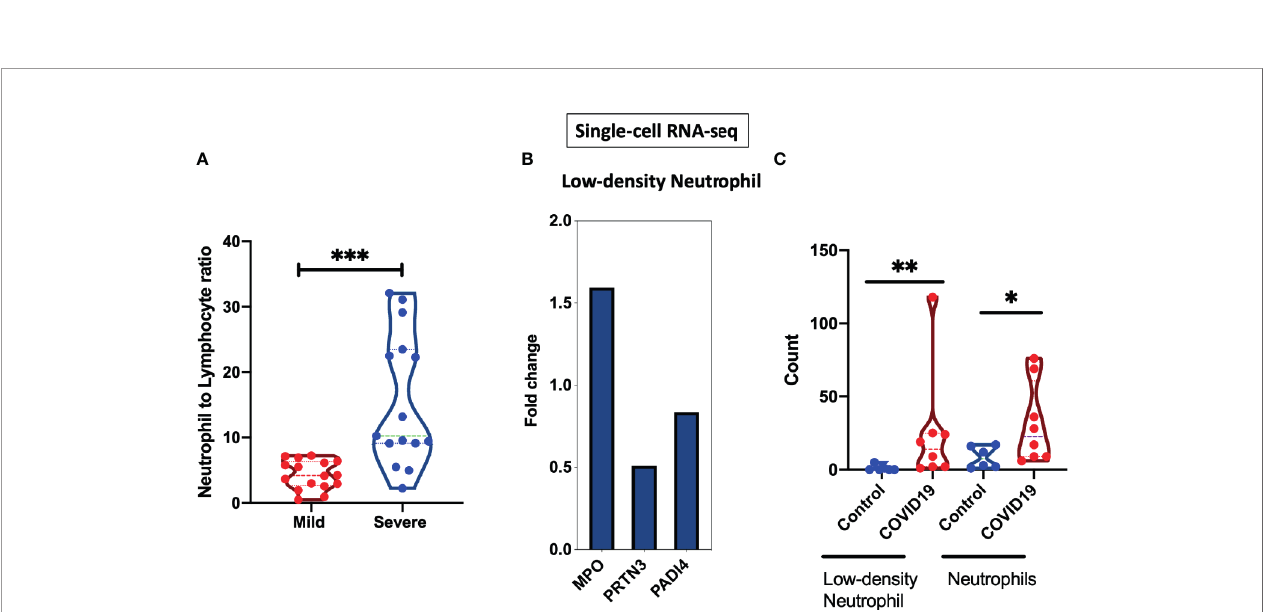
FIGURE 4 | Neutrophil to lymphocyte ratio and gene expression isolated from severe COVID-19 patients. (A) Neutrophil to lymphocyte ratio from whole blood of 16 mild and 15 severe COIVD-19 patients were compared (PRJNA646224). This ratio was signi fi cantly higher in severe COVID-19 (B) Single-cell RNA sequencing was performed on PBMCs from six severe COVID-19 patients and seven healthy controls (GSE150728). Differential expression of MPO, PRTN3, and PADI4 within the low- density neutrophils cluster. (C) Increased counts of low-density neutrophil and canonical neutrophil during severe COVID-19 infection. The count value represents the absolute cell number within the PBMCs. Unpaired student t-test was used to compare between the independent groups. ∗ p < 0.05, ∗∗ p < 0.01, ∗∗∗ p <